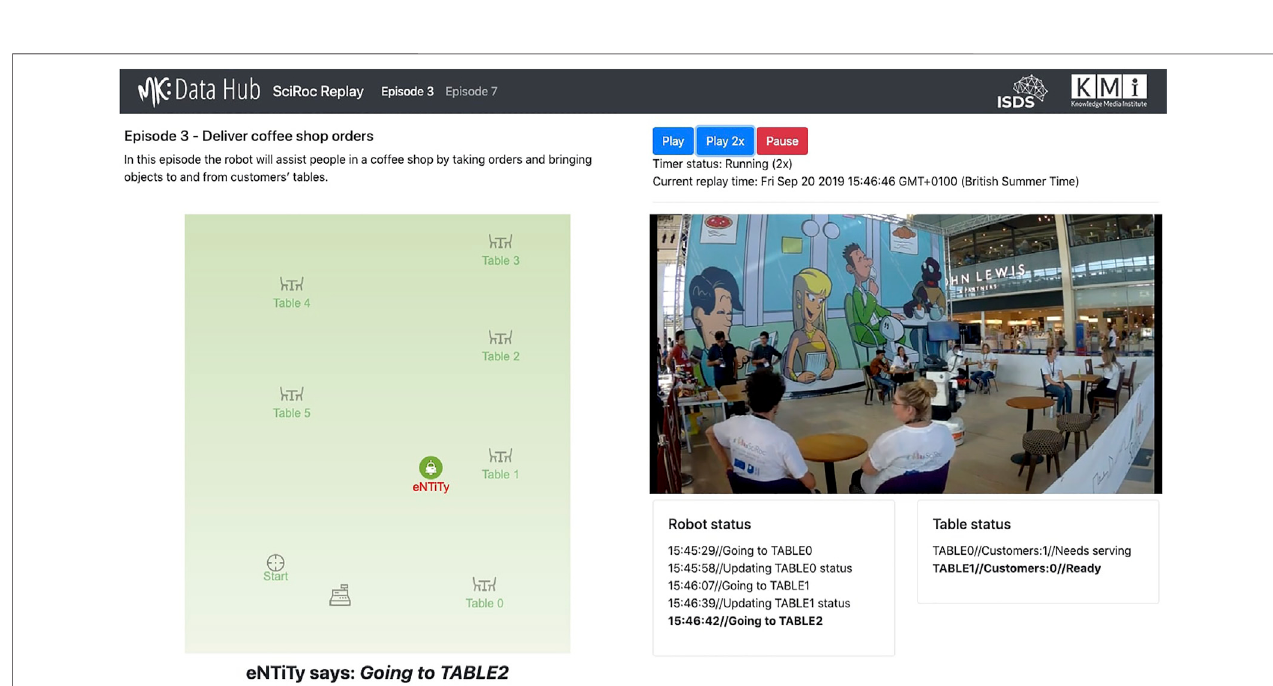
FIGURE 4 | Interface of the SciRoc Replay Demo for the “ Deliver coffee shop orders ” challenge. The left hand side shows the map of the arena with the current position of the robot and its most recent status message. On the right hand side, we can see a synchronised video of the trial showing the robot in action.